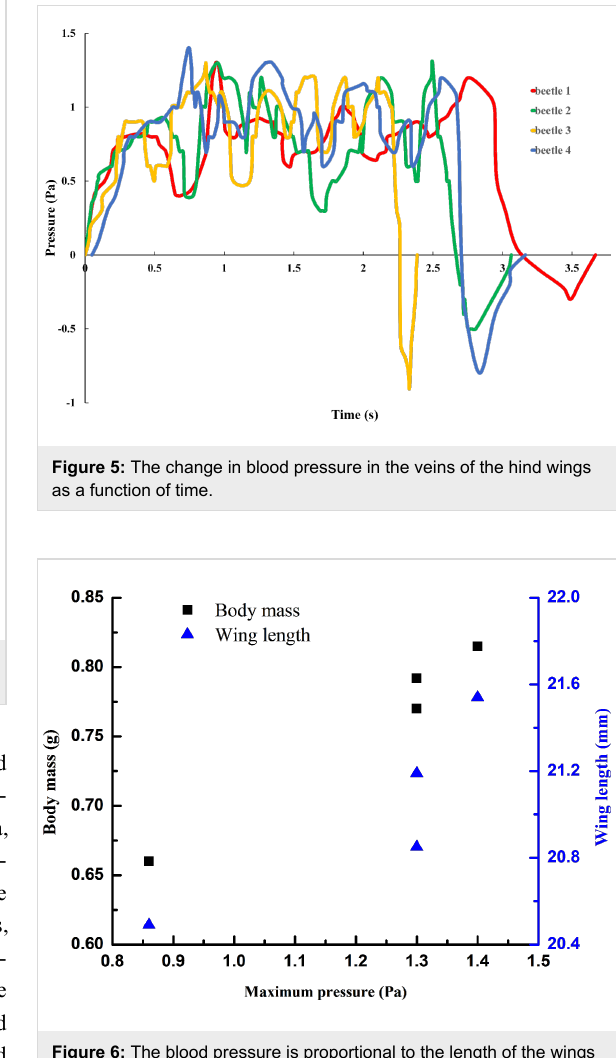
This expansion time is a little quicker than that measured in Figure 4 (3.31 s). It is supposed that in that test (Figure 4), the beetle was fully expanded and fixed, while in this test (Figure 5), the beetle was able to move freely, which acceler- ated blood flow in a manner similar to that described in